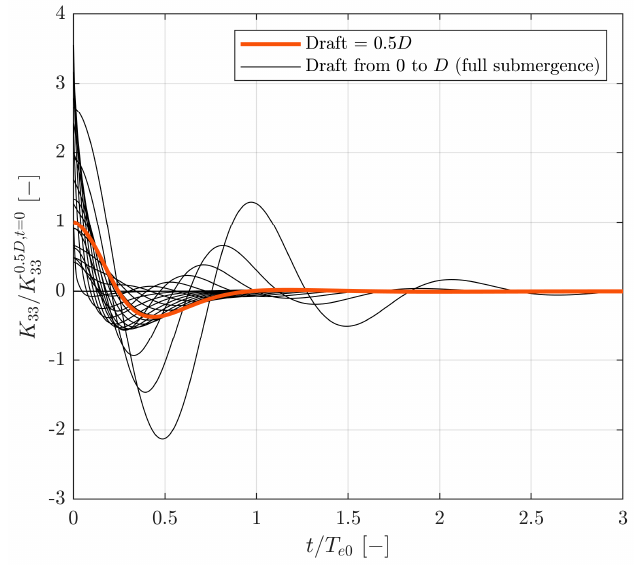
Figure A5. Normalized radiation impulse response functions for different drafts. Steps of 15 mm draft are shown for better visualization.